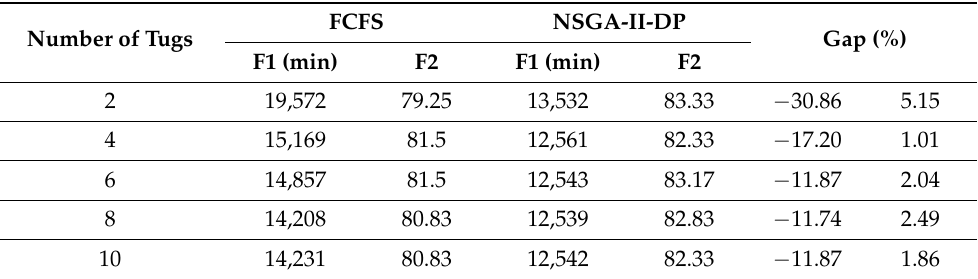
Figure 12. Comparison between the results of the NSGA-II-DP and FCFS strategies for different numbers of vessels. Table 11. Comparison between the results of the total vessel scheduling time obtained using the traditional FCFS strategy and those obtained using the NSGA-II-DP algorithm for different numbers of